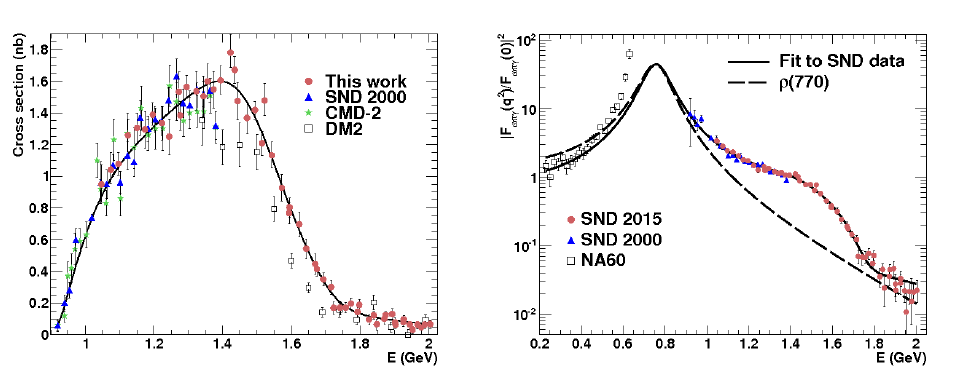
Figure 3. Left panel : The e + e − → ωπ 0 → π 0 π 0 γ cross section measured by SND at VEPP2000 and VEPP- 2M[14, 15], and by CMD-2[16] and DM2[17] experiments. Only statistical errors are shown. The curve is the result of the fit to SND 2000 and SND 2013. Right panel : The γ ∗ → ωπ 0 transition form factor. The solid curve is the result of the fit to the SND data with the VMD model. The ρ (770) contribution is shown by the dashed curve.